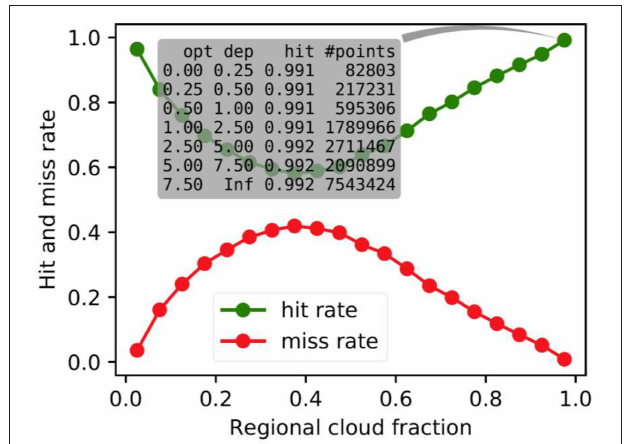
FIGURE 6 | Hit and miss rates as functions of cloud fraction (see text), showing that the hit rate is very high when the sky is either totally clear or overcast but the hit rate decreases rapidly when the sky becomes fractured. The inset table groups pixels with cloud fraction > 0.95 by optical depth, showing that when the factor of cloud fraction is excluded, the hit rate remains close to unity even for thin clouds with optical depth less than 0.25. Data was collected over both land and water for the region (110 ◦ E , 155 ◦ E , 10 ◦ S , 45 ◦ S ) from 6th Jul 2015 to 30th Jun